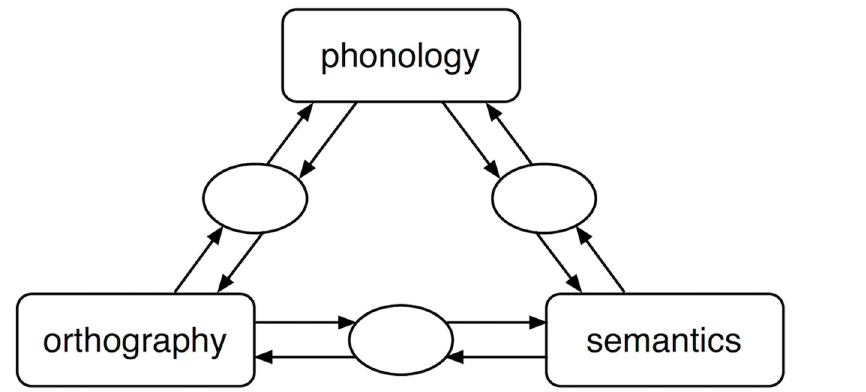
Fig 1. Triangle model. Basic architecture of the triangle